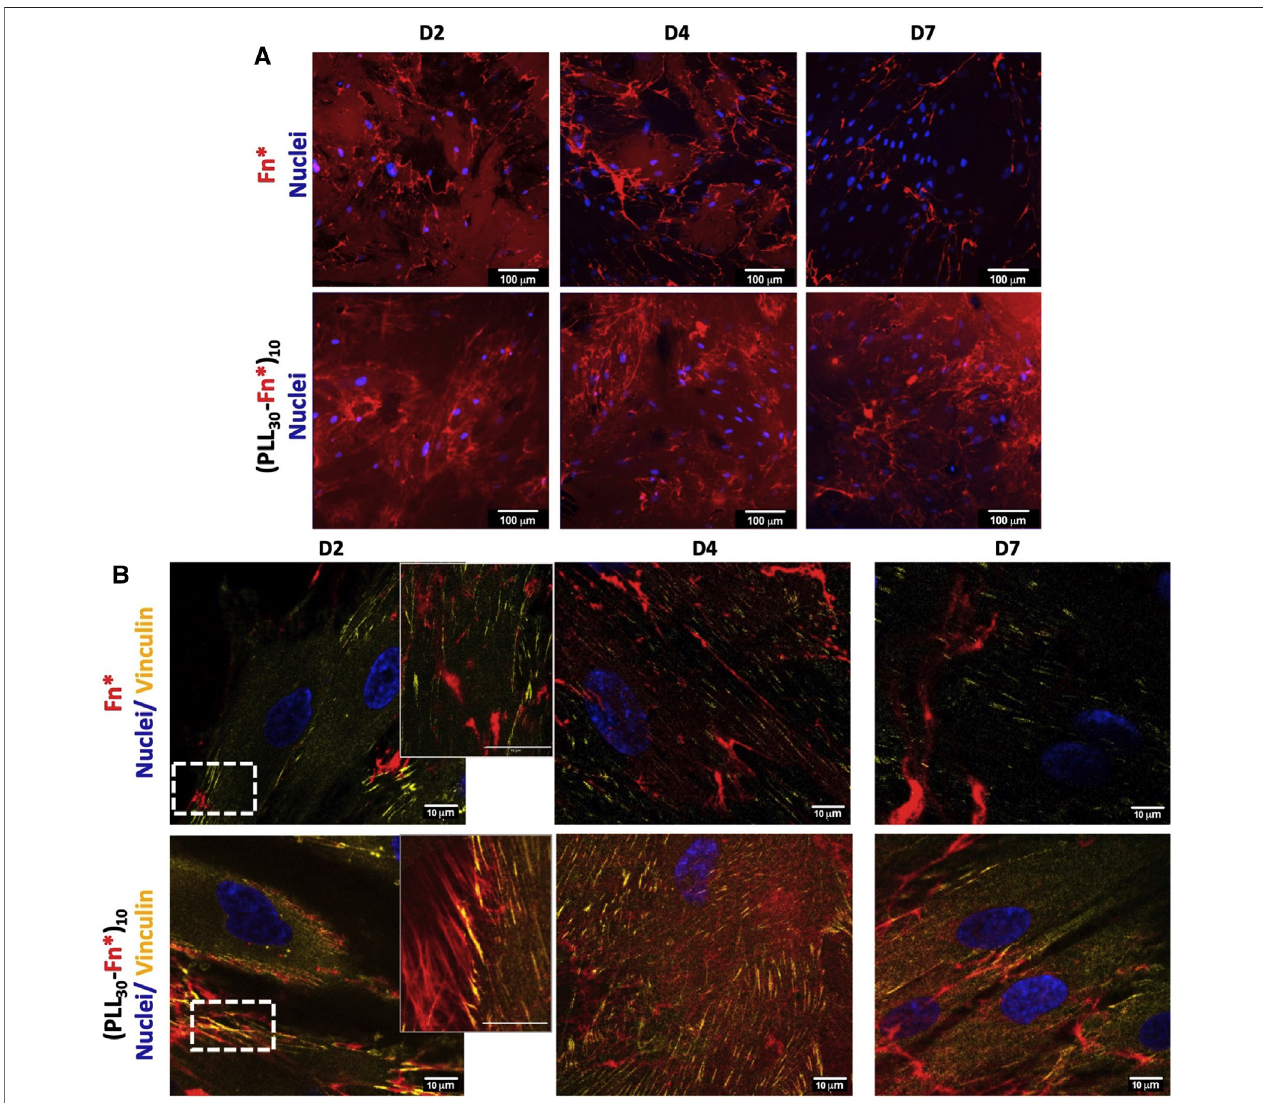
FIGURE 6 | (A) Fn reorganization by human gingival fi broblasts (HGF) on the Fn monolayer and (PLL 30 -Fn) 10 fi lms. Cells were cultured for 2, 4, and 7 days and stained for nuclei (DAPI — blue). (PLL 30 -Fn) 10 fi lms exhibit an increase in Fn fi bril formation over time. Scale bar (cid:1) 100 μ m. (B) Distribution of focal adhesion sites of HGF cells on Fn monolayer and (PLL 30 -Fn) 10 fi lms analyzed by immunostaining of vinculin (Star Red — yellow) and nuclei (DAPI — blue). The second column corresponds to magni fi ed images of the white rectangles of the fi rst column. Vinculin is particularly linked to Fn fi brils in (PLL 30 -Fn) 10 fi lms. Scale bar (cid:1) 10 μ m. Fn was previously labeled with Alexa Fluor 568 for both